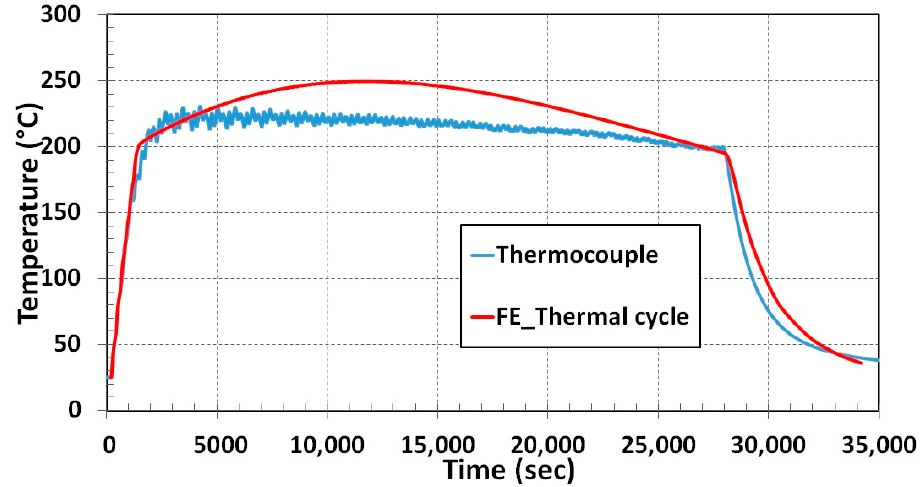
Figure 17. Temperature comparison between experiment and simulation for 3D structure.